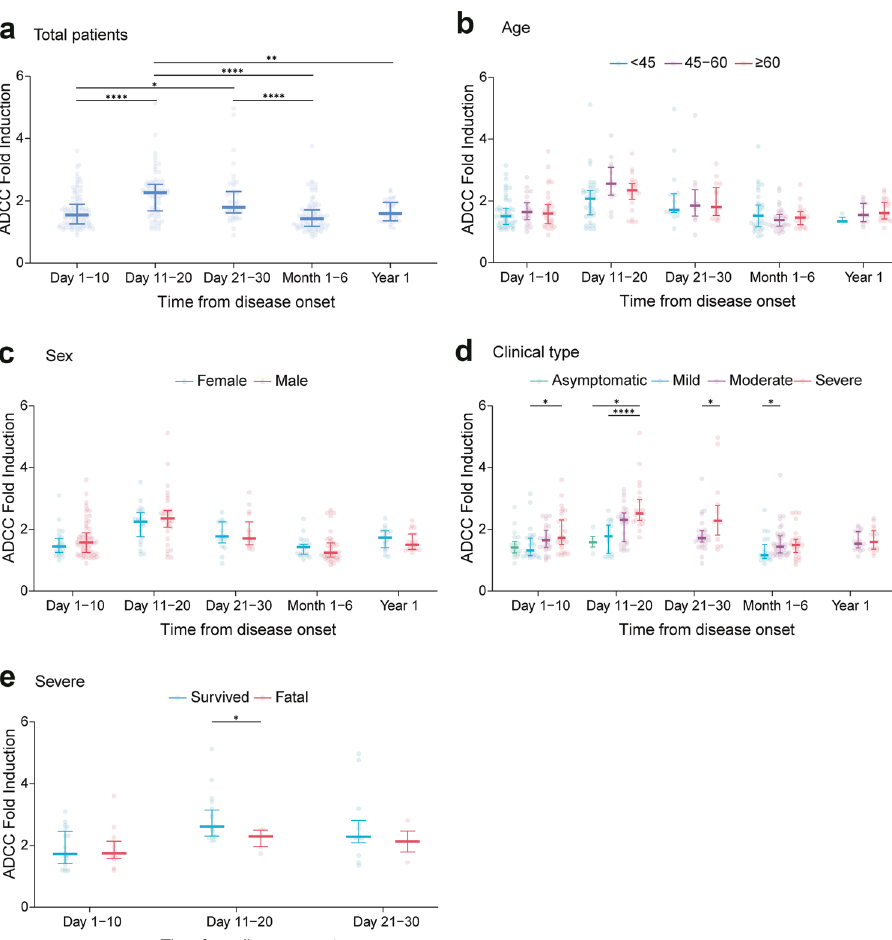
Fig. 1 Antibody-dependent cellular cytotoxicity (ADCC) in COVID-19 patients over time. a Total patients ( n = 255). b Patients strati fi ed by age groups (97 patients were <40 years old; 74 patients were 40 – 60 years old; 84 patients were ≥ 60 years old). c Patients strati fi ed by sex (164 males and 91 females). d Patients strati fi ed by clinical phenotype (21 asymptomatic, 58 mild, 94 moderate, and 82 severe). e Patients strati fi ed by clinical outcomes (30 survived and 19 fatal). Dots represent values for individual detection, and lines and error bars indicate the median and interquartile range, respectively. In a , c , e , Mann – Whitney U test was performed. In b , d , the multiple comparisons among the groups were made using Kruskal – Wallis test followed by Bonferroni post hoc correction; * P < 0.05, ** P < 0.01, **** P < 0.0001. COVID-19 coronavirus disease binding IgG antibody to that of Nabs (i.e., all signi fi cant higher level for RBD vs. NTD; S2 vs. NTD, RBD vs. S2; Fig. 3c). ADCC activity of patients and immunized mice against VOCs To compare differences among the D614G reference strain and three SARS-CoV-2 VOCs (B.1.1.7 variant, B.1.351 variant, and P.1 variant) in term of their ability to trigger the ADCC response, we